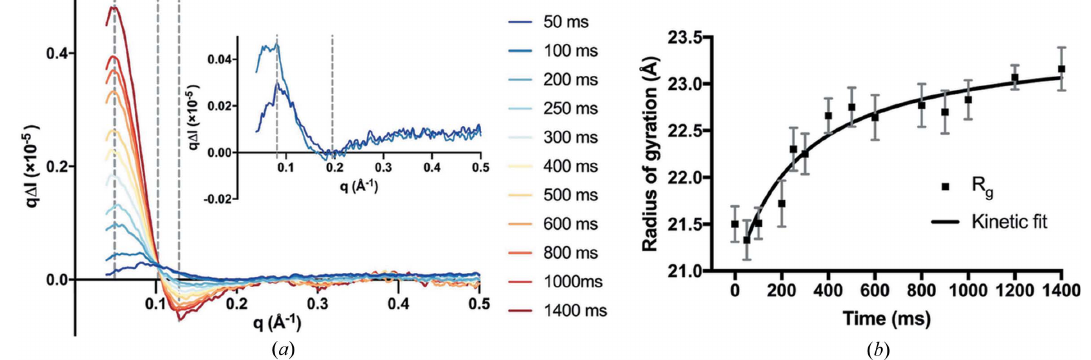
Figure 2 Time-resolved SAXS data following photo-decaging of NPE-ATP. ( a ) Plot of the scattering difference curves ( q (cid:3) I versus q ) calculated by subtracting the protein scattered with a negative laser offset ( (cid:5) 100 m s) from all the subsequent time-point measurements. Inset shows the difference curves of the first two time points (50 and 100 ms). ( b ) Radius of gyration representing NBD dimerization and kinetic fit with an increase in R g over time (black squares with corresponding standard deviations). The time points after laser excitation were fitted with a second-order kinetic function (black line). The calculated rate constant for dimerization ( k dim ) from the fit is 6200 M (cid:5) 1 s (cid:5) 1